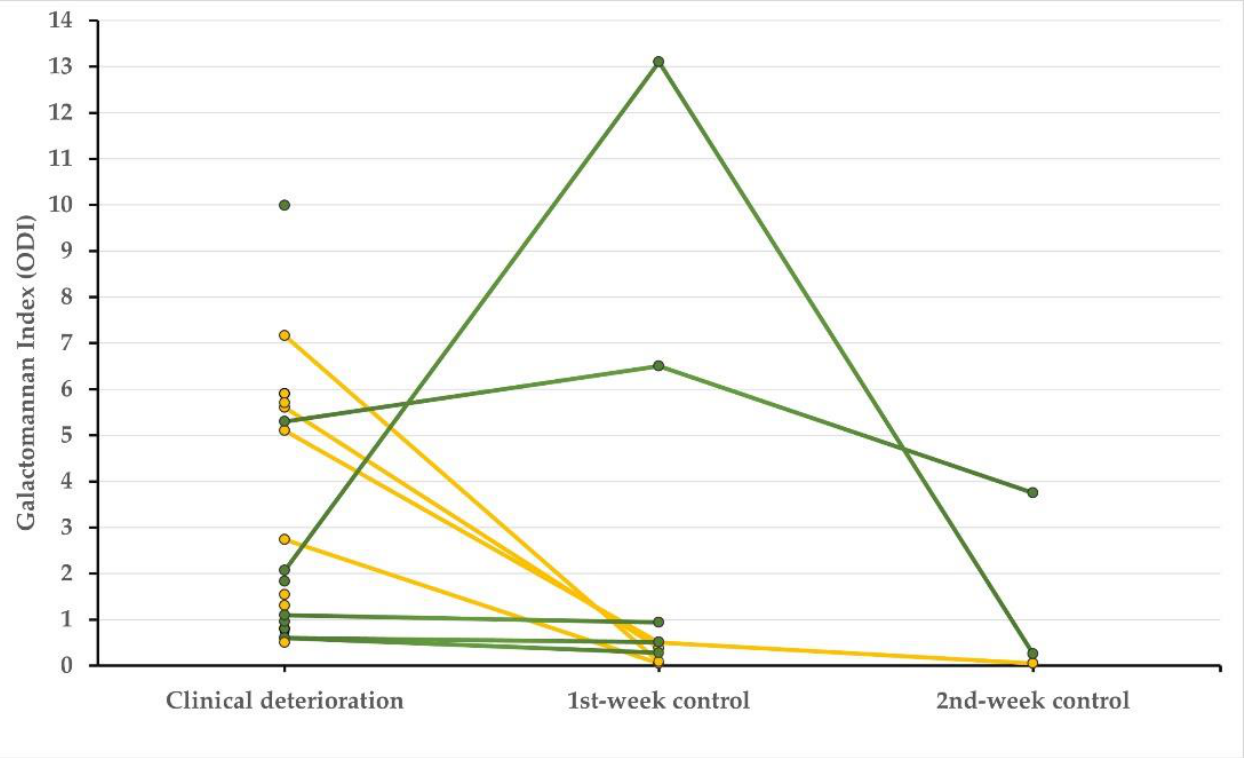
Figure 1. Galactomannan values in consecutive tracheal aspirate samples during ICU stay in patients diagnosed with COVID-19 pneumonia and CAPA in progress. Black lines and symbols denote patients who died, and those who survived are indicated in grey. Table 1. Microbiological data from patients fulfilling the CAPA-IP criteria.